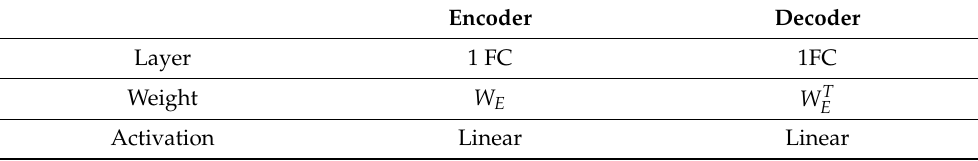
Table A1. Autoencoder implementation. Network architecture. FC denotes a fully connected layer.